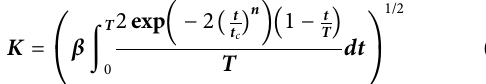
Figure 1A : First, we convert the raw speckle images to speckle contrast images using Eq. 1 . Second, we compute the β and the dynamic scattering type n by the dynamic light scattering imaging technique. Third, we substitute the β and n to Eq. 2 , and the inverse correlation time ( T / τ c ) is solved to represent the fl ow velocity. Eventually, we assess the fl ow with the SFI, MFI, and